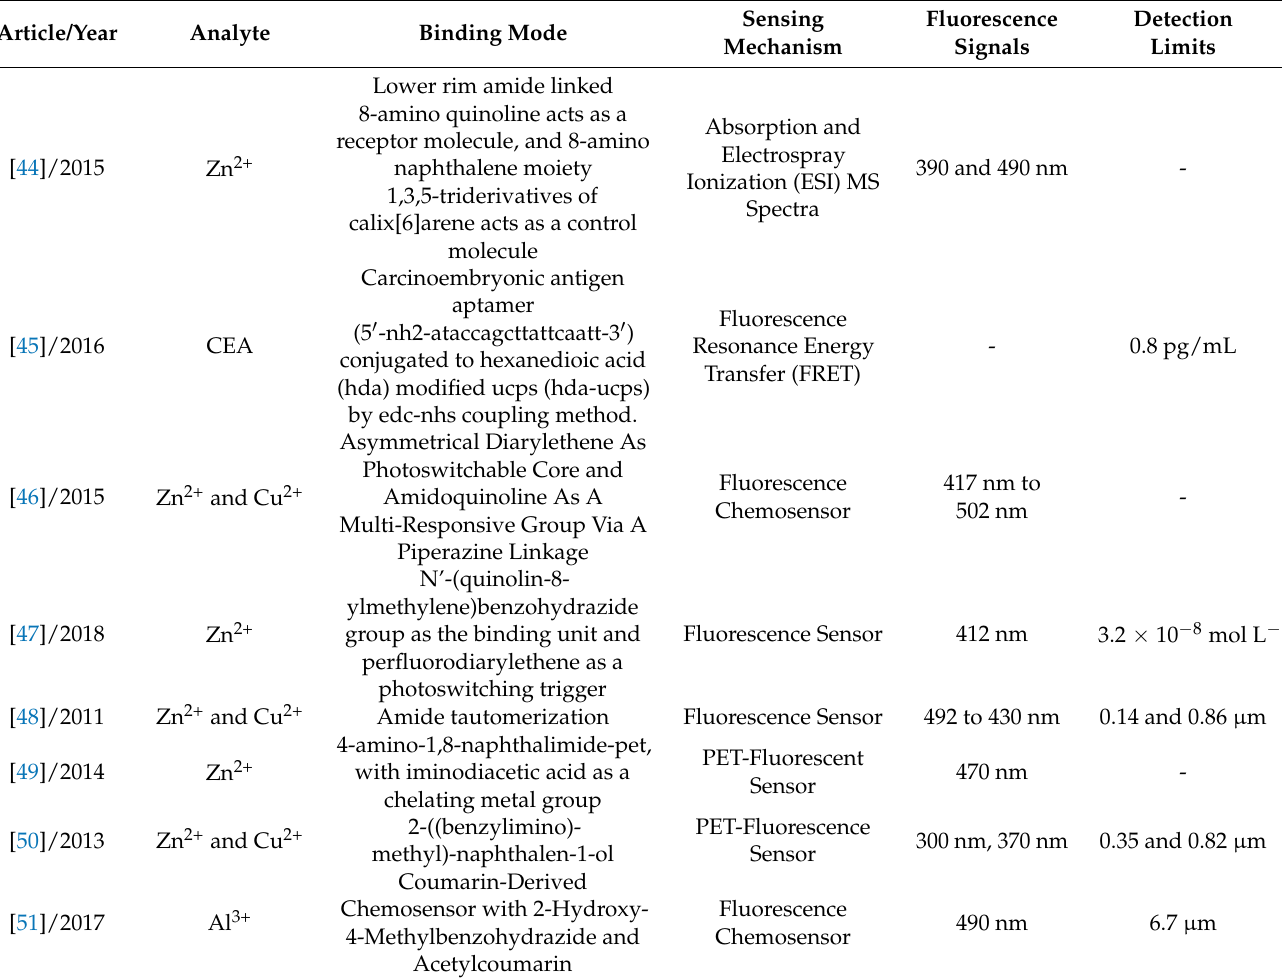
Table 1. The comparisons and assessments of collected studies that related to the fluorescence probe. Article/Year Analyte Binding